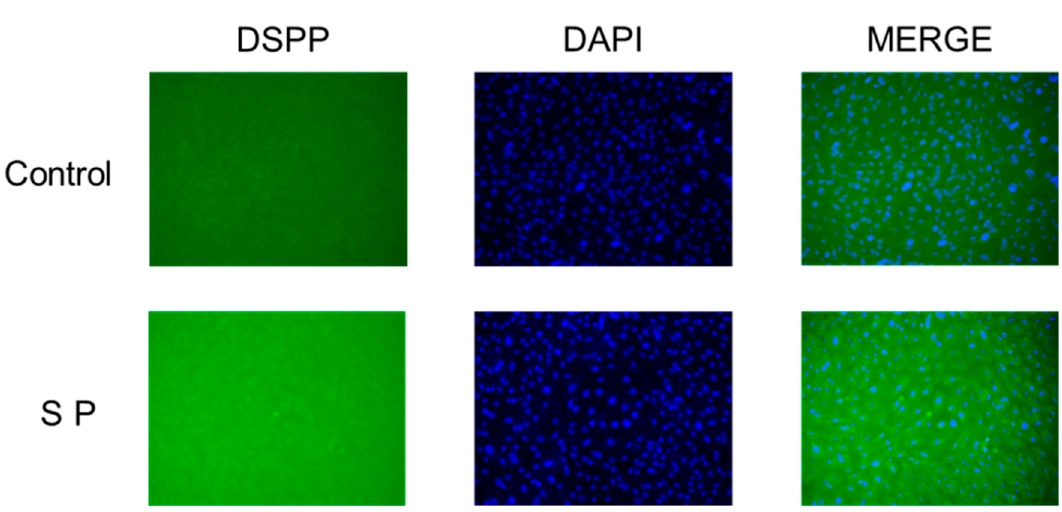
Figure 6. KN-3 cells treated with or without SP were incubated with anti-DSPP monoclonal antibody. Cells were incubated with a fluorescence-labeled secondary antibody. The samples were stained with DAPI solution. Scale bar = 100 µm.